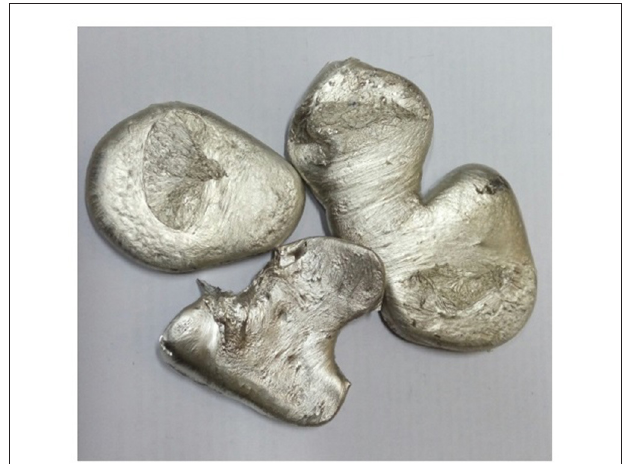
FIGURE 8 | Photomicrograph showing the effect of CaO addition on melt protection. Silvery surface shine of a cast Mg-0.4Al-1CaO (wt%) alloy piece solidified without protective gas (reproduced with permission from Rafiei et al., 2018; https://www.civilica.com/Paper-IMES12-IMES12_010.html).